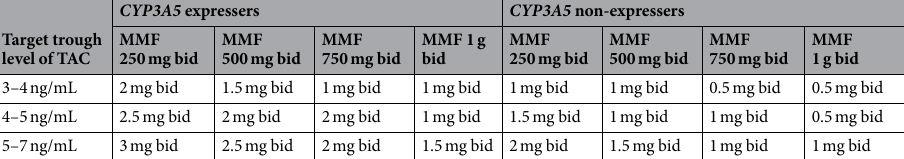
Table 3. Suggested algorithm on tacrolimus dosing based on CYP3A5 and the dose of mycophenolate mofetil. bid, twice daily; CYP3A5 expresser, CYP3A5 * 1/ * 1 or CYP3A5 * 1/ * 3 carriers; CYP3A5